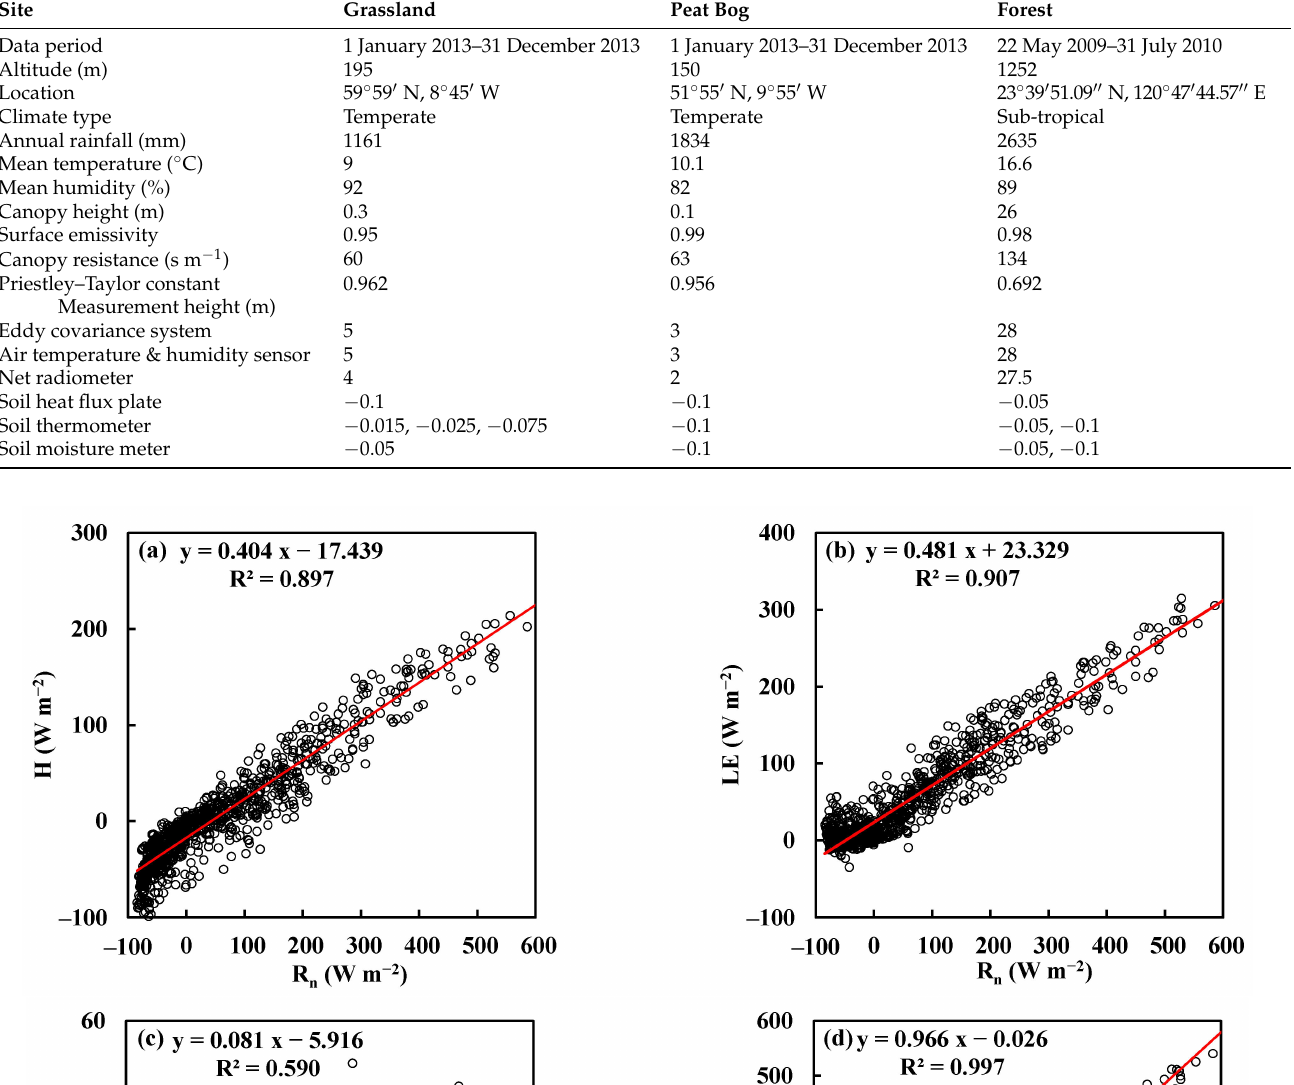
Table 1. Summary of site features and instrumental heights at the grassland, peat bog, and forest. Grassland Peat Bog Forest